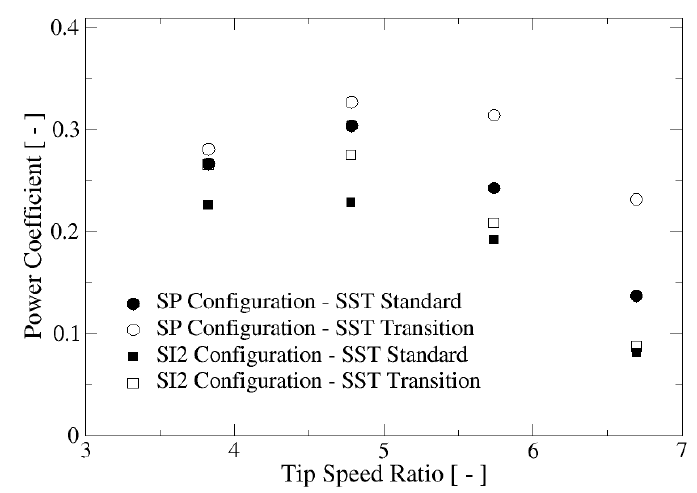
Figure 14. The power coefficient versus tip speed ratio for the two evaluated turbulence models. SP and SI30 configurations.